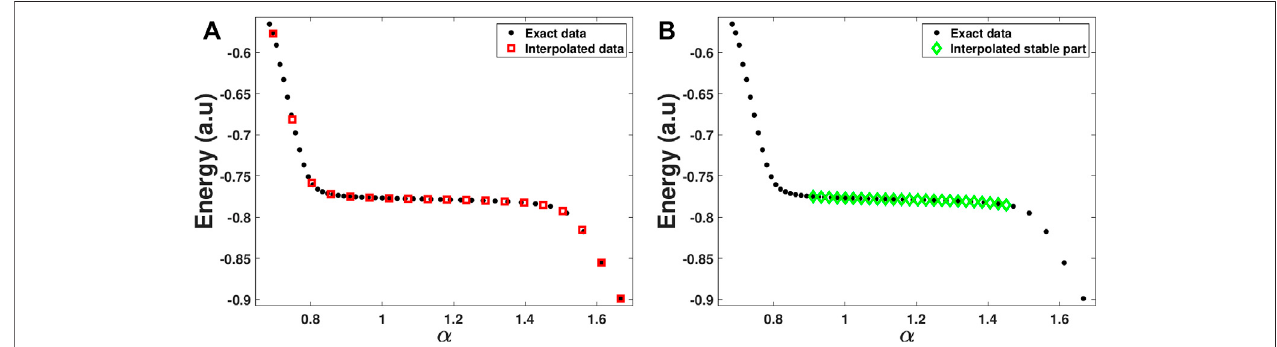
FIGURE 3 | The stabilization graph of the He**(2 s 2 ) resonance state, where the real energy level is plotted as a function of a real parameter ( α ) that controls the diffusenessoftheGaussianbasisfunctions.TheplotillustratesthedifferentstepswithintheautomatedRVPalgorithm. (A) Calculated(blackcircles)andinterpolated(red squares) data points. (B) The interpolated stable region produced by step 1 of the automated RVP algorithm (green diamonds) that serves as input for the Padé/ Schlessinger point